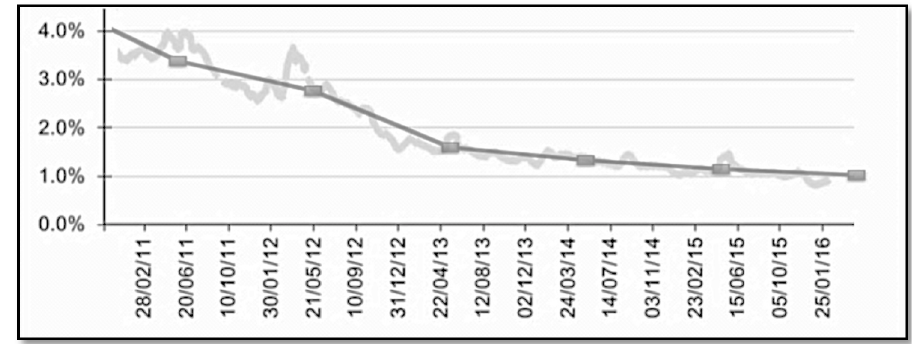
Figure 2. Percentage of the active contributors relative to total number of accounts.